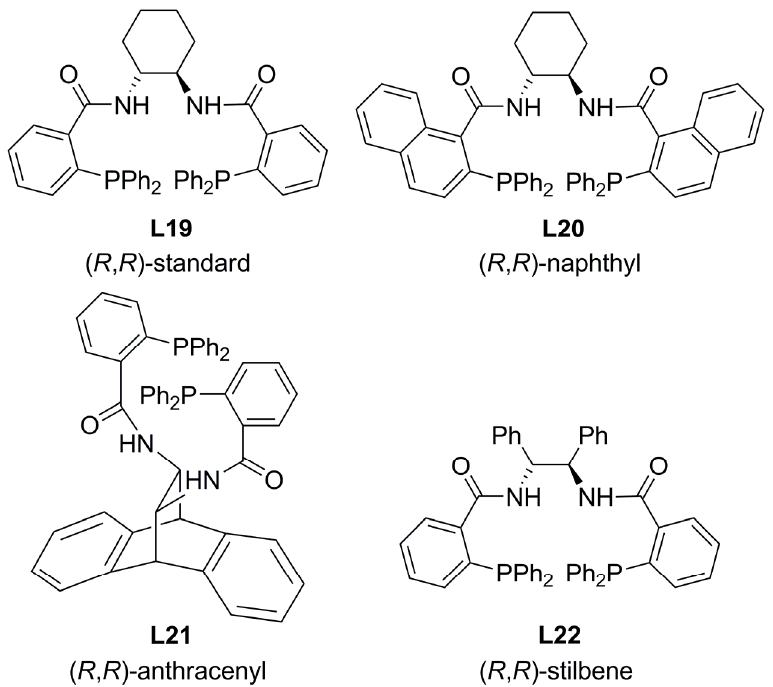
Figure 6. C -symmetric diphosphine DPPBA-based 2